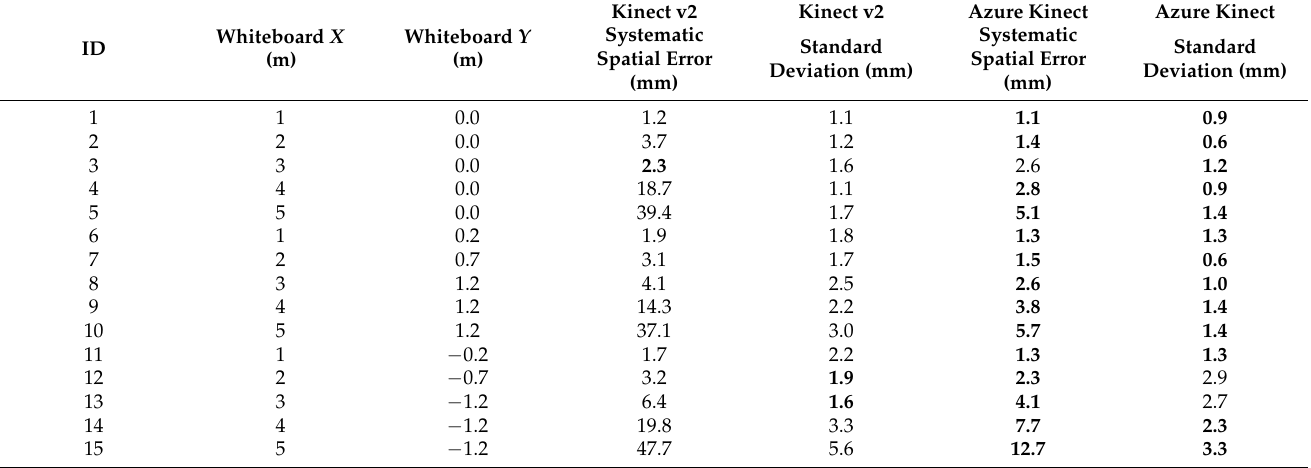
Figure 13. Contour plot of the systematic spatial error over the horizontal plane for the Kinect v2 sensor.